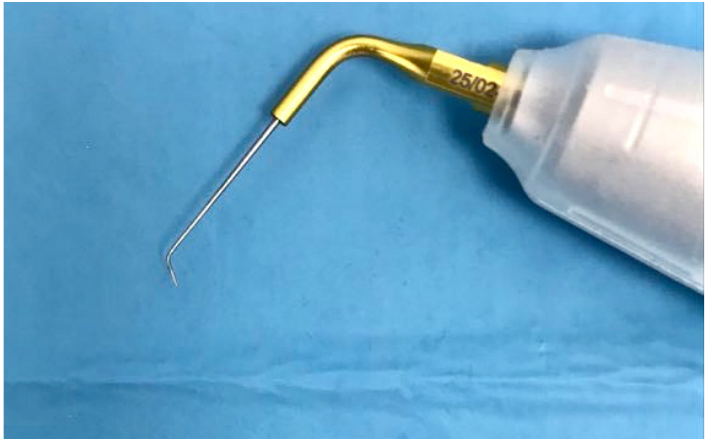
Figure 1. Modified ultrasonic tip.